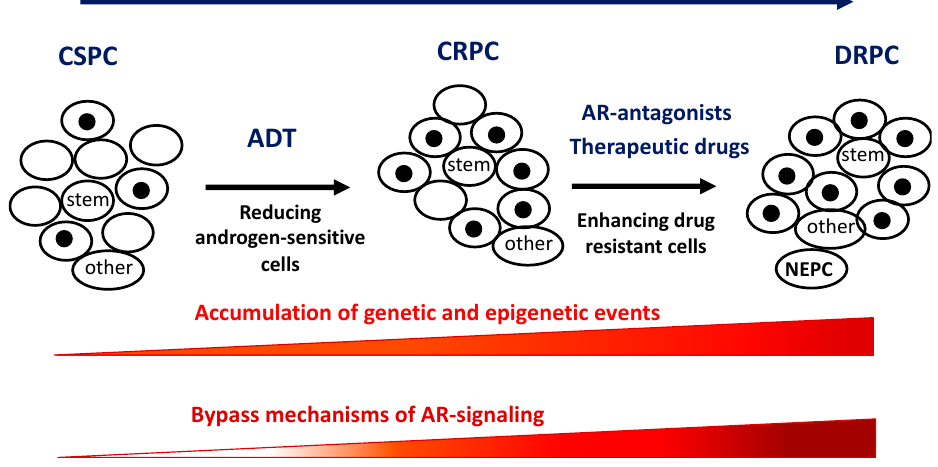
Figure 1. Schematic view of prostate cancer tumor evolution upon therapy. In general, due to accumulation of mutations, a tumor is composed of many cancer cell types leading to tumor cell heterogeneity. Cancer consists also of cancer stem cells (stem) and other non-cancerous cells (other, including cancer -associated fibroblasts and immune cells). Androgen-deprivation therapy (ADT) is mostly successful inhibiting the growth of androgen-sensitive PCa cells. However, castration-resistant cells may be selected by the treatment and accumulate. Treatment with AR antagonists and other therapeutic drugs, including chemotherapy and radiation, might select for drug resistant PCa cells leading to a more aggressive tumor (such as NEPC). Associated with the tumor evolution, during tumorigenesis PCa develops a variety of androgen bypass signaling.